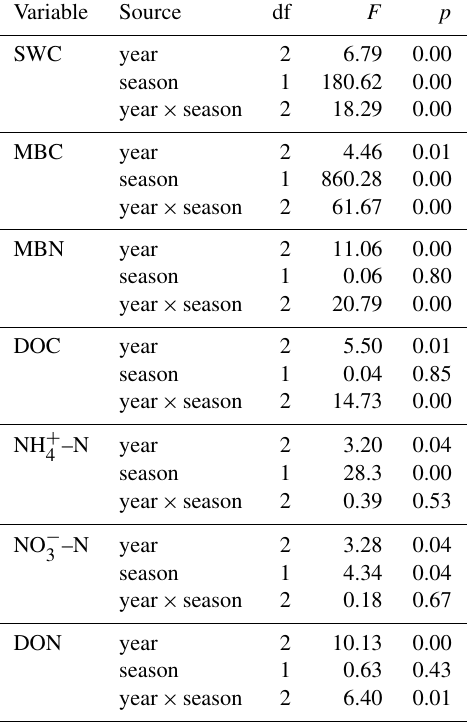
Table 1. Results from two-way ANOVA comparing growing season (May to October) and nongrowing season (November to April) val- ues across 3 years of study for SWC, MBC, MBN, DOC, NH4 + –N, NO − –N, and DON in the alpine meadow. 3